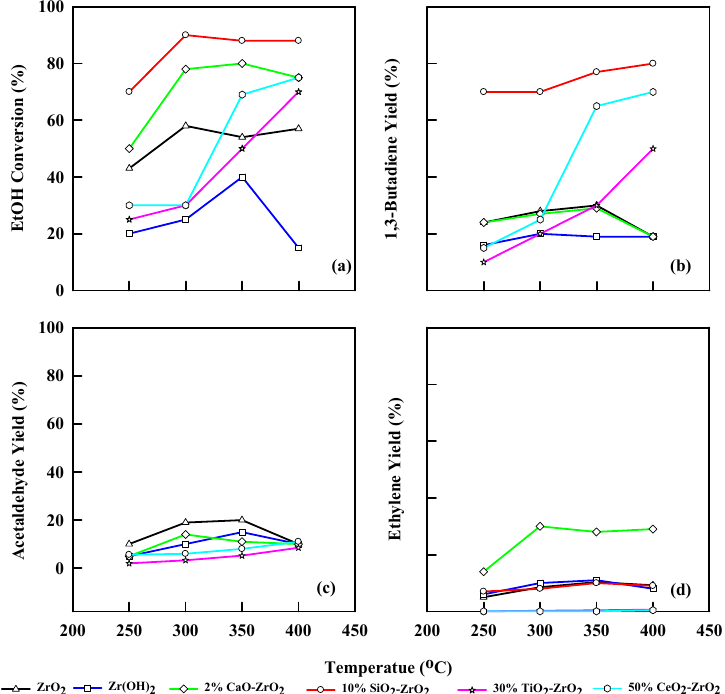
Figure 6. Plot of ethanol conversion ( a ), yields of 1,3-butadiene ( b ), acetaldehyde ( c ), and ethylene ( d ) vs. reaction temperature for different modified commercial catalysts. WHSV: 1.25 h − 1 , catalyst: 0.4 g, N 2 : 30 mL/min.